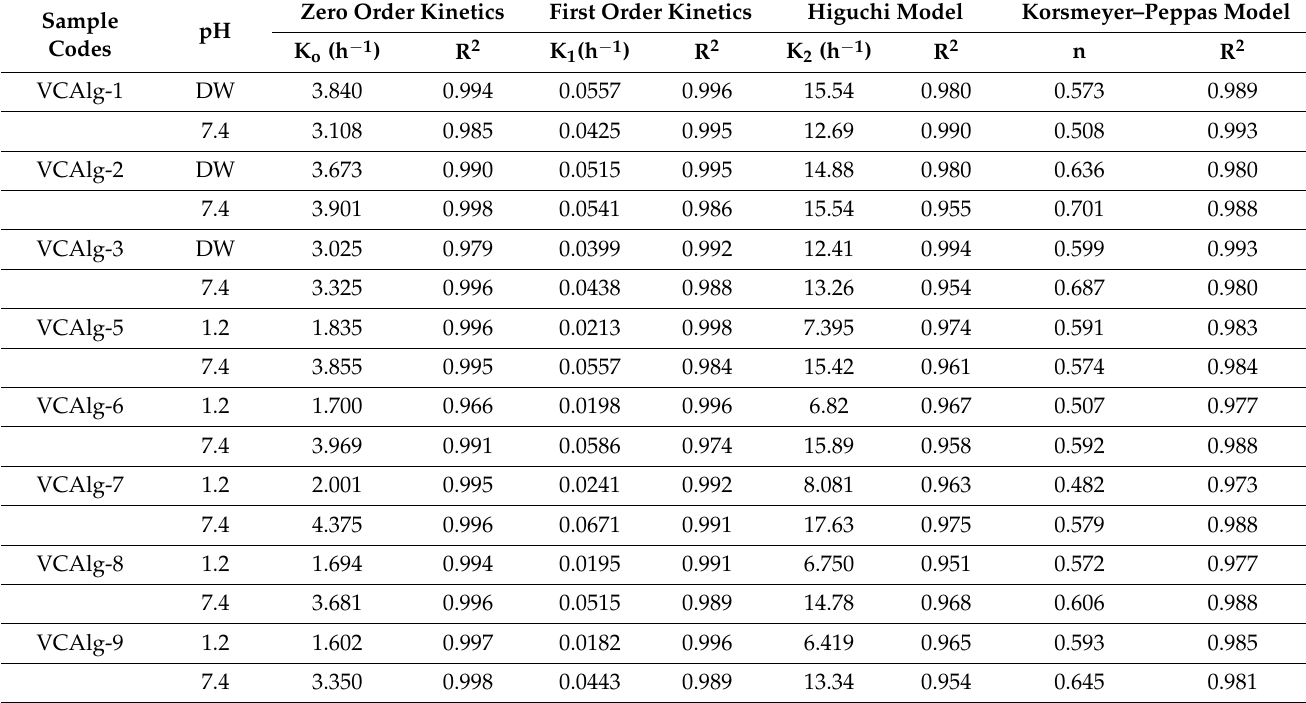
Table 4. Drug release kinetics of chemically cross-linked thermoresponsive Poly (NVCL-g-NaAlg) in situ depot hydrogels at 35 ◦